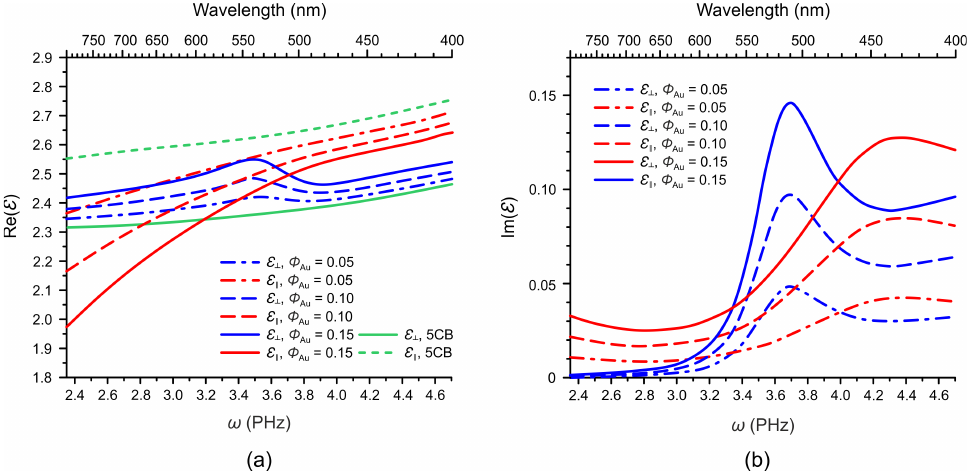
Figure 2. Real ( a ) and imaginary ( b ) parts of the transverse and longitudinal components of the high-frequency dielectric susceptibility of the 5CB nematic nano-composites for different values of the volume fractions of